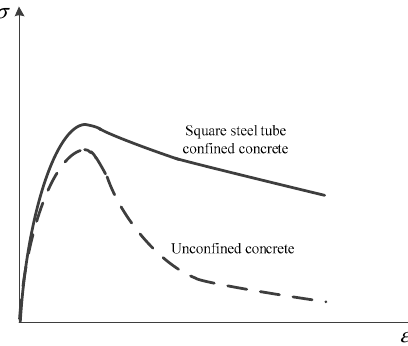
Figure 4. The constitutive model of concrete confined by a square steel tube.